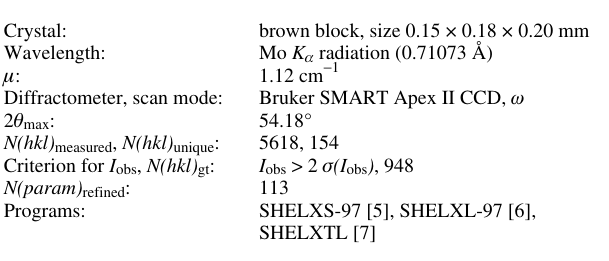
Table 1. Data collection and handling.